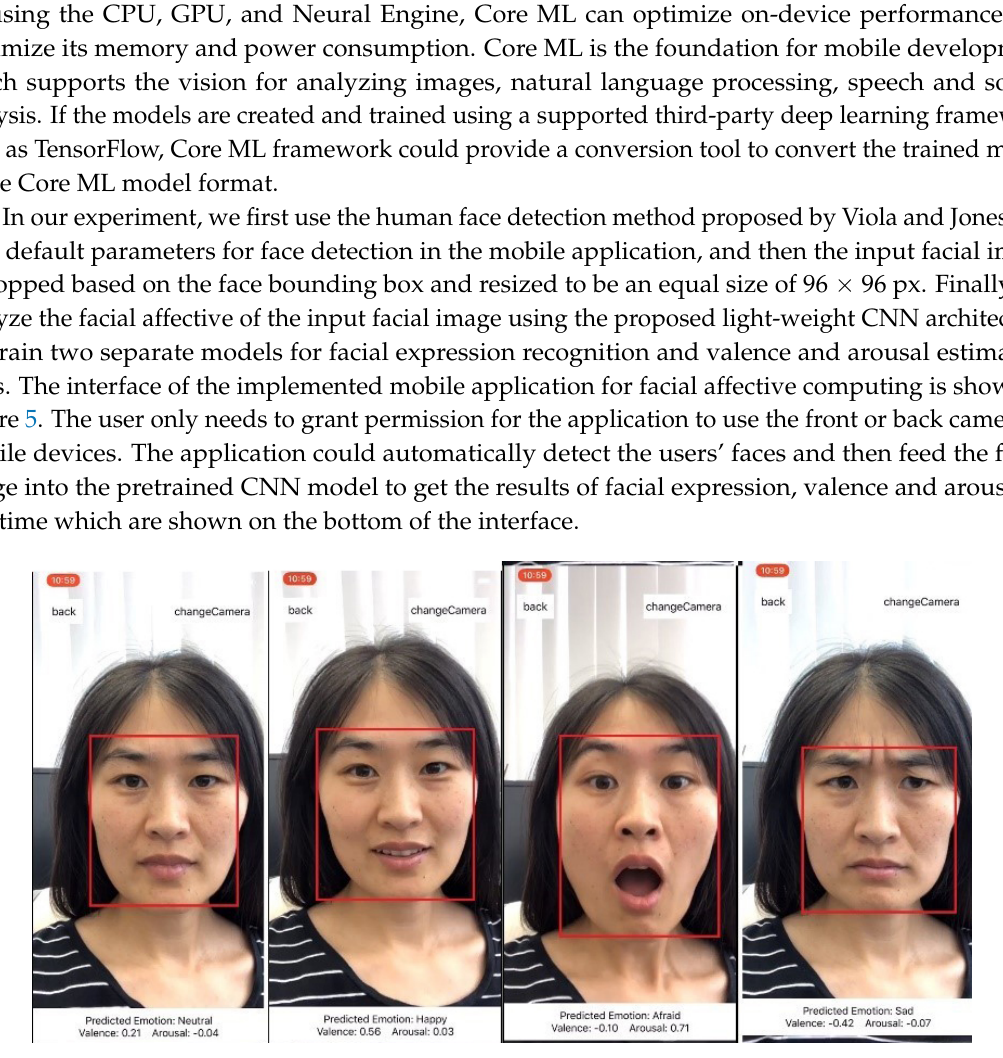
Figure 5. Implementation of the proposed model on the iOS